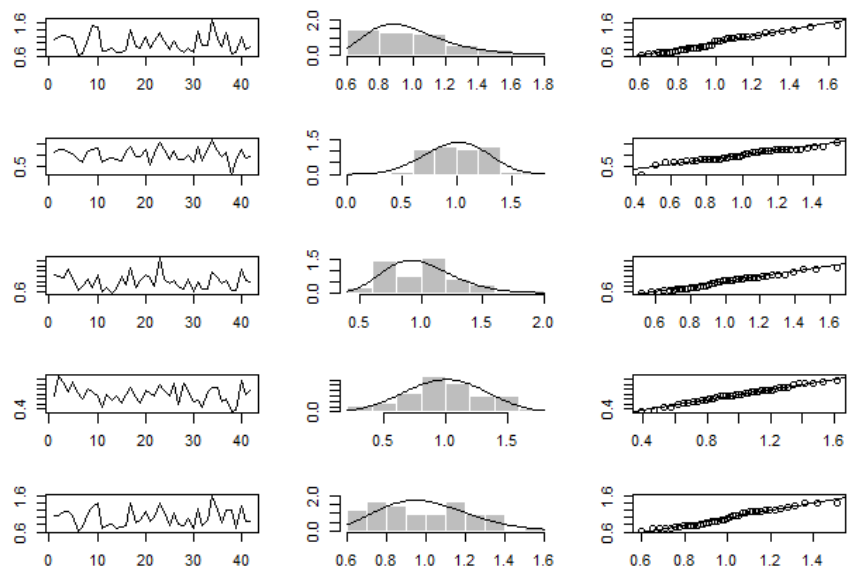
Figure A1. Time series, histograms with densities of theoretical laws and QQ-plots of the volume variable of the five studied stations. From top to bottom: station 3, 7, 8, 11 and